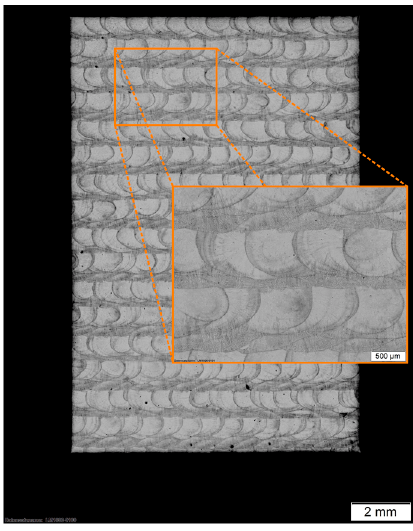
Figure 12. x – z cross section of heat treated 316L-Si placed 45° to the scanning direction.